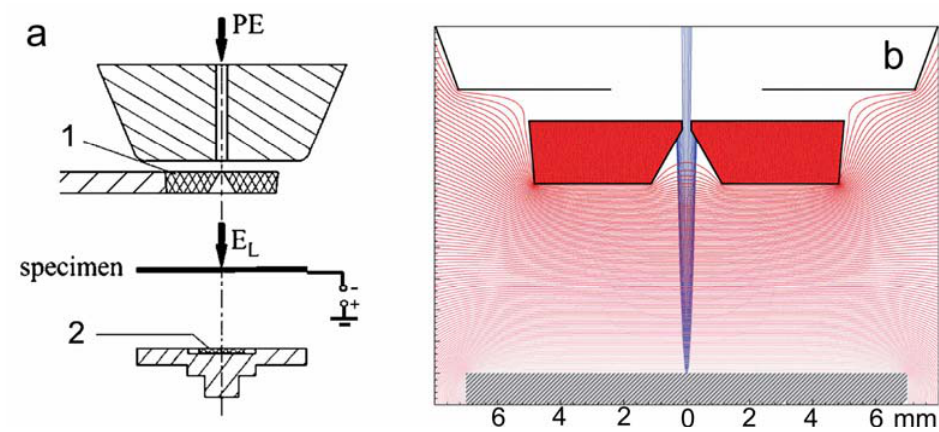
Figure 5. ( a ) Principal scheme of a cathode lens configuration with a negatively biased specimen, detector of reflected electrons 1 based on a coaxial bored single-crystal